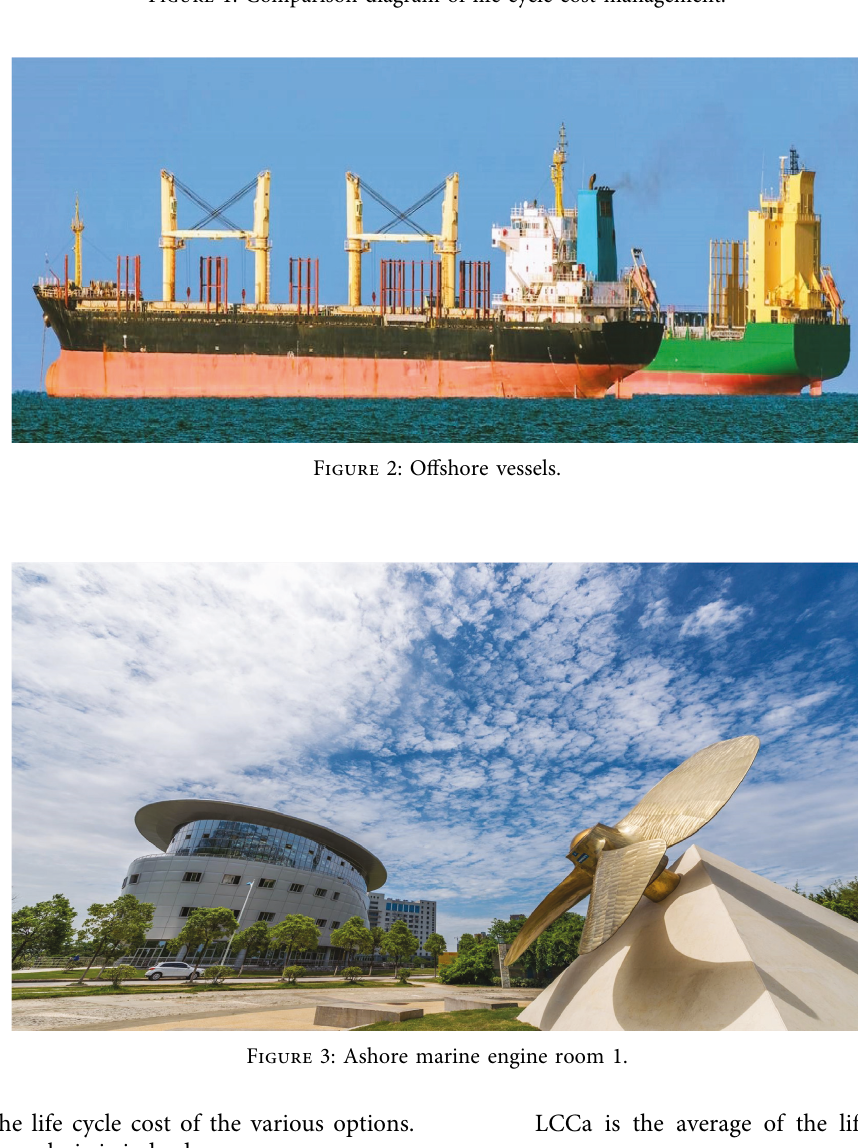
Figure 1: Comparison diagram of life cycle cost